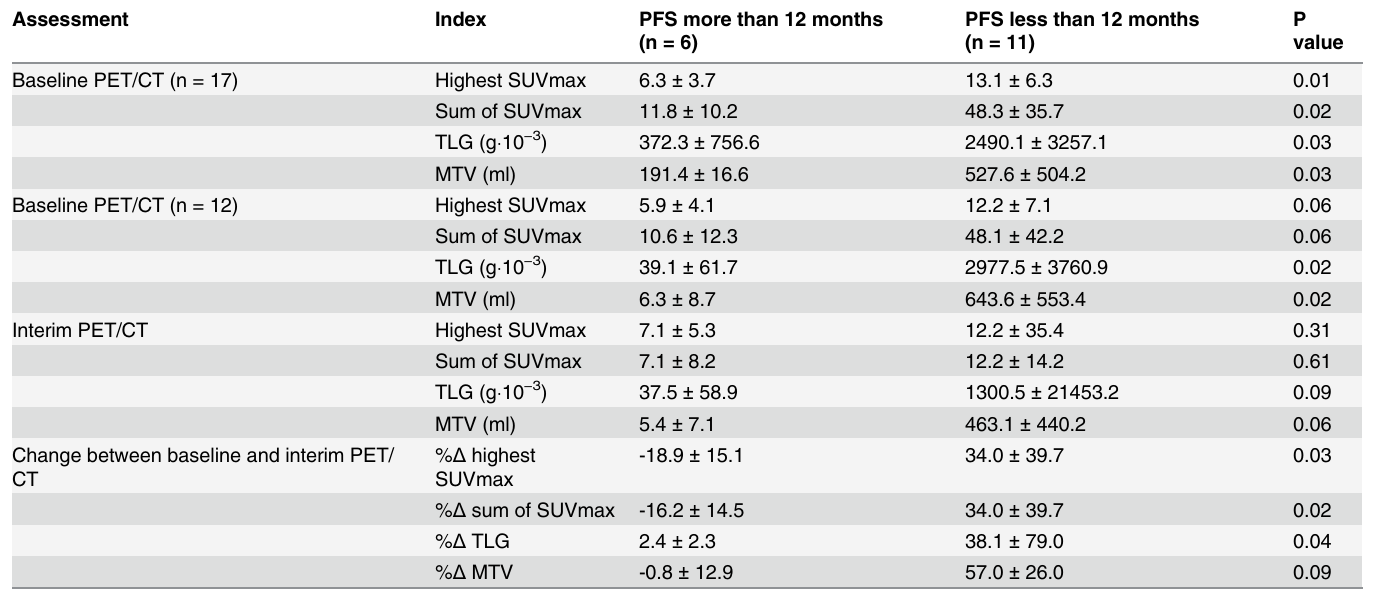
Table 2. Comparison of Metrics for Prediction of Progression Free Survival. Assessment